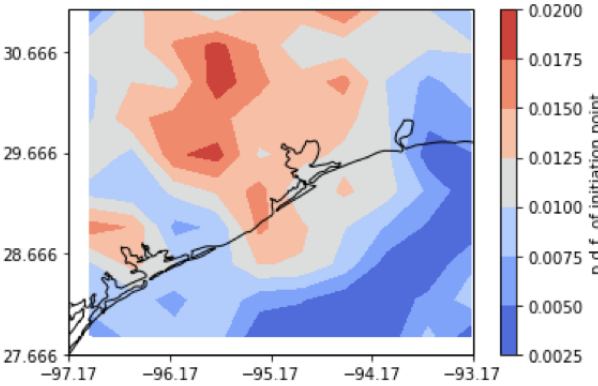
Figure 14. Distribution of isolated cell initiation location during 2015–2017.